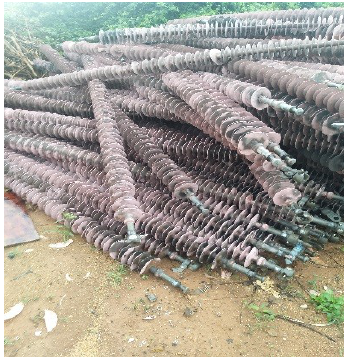
Figure 2. Landfill site of waste composite insulators.